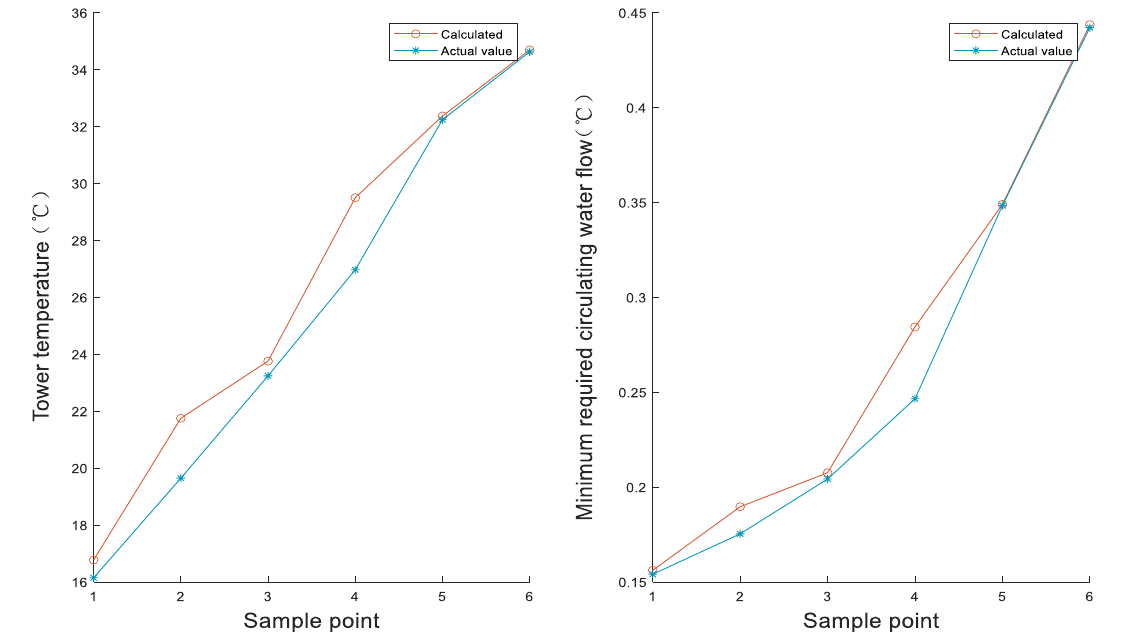
Fig. 5 Comparison of calculated values and actual ones of relevant parameters when the system is running smoothly